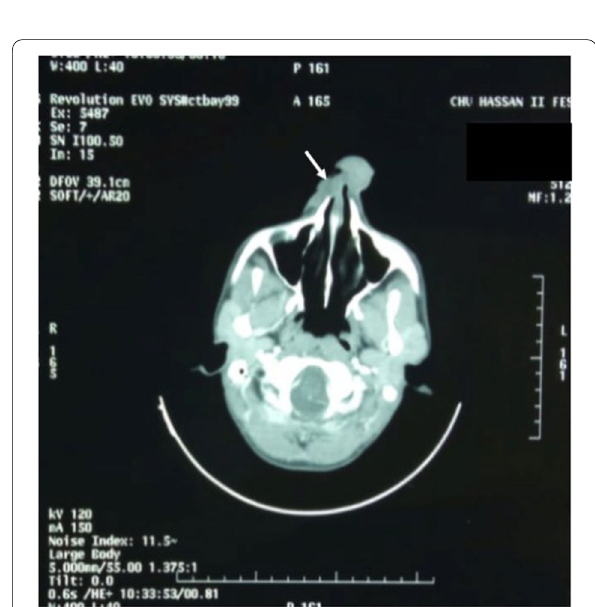
Fig. 2 CT scan axial view with contrast showing an enhanced tumor involving the dorsum nasi and the septum with no evidence of bone destruction (white